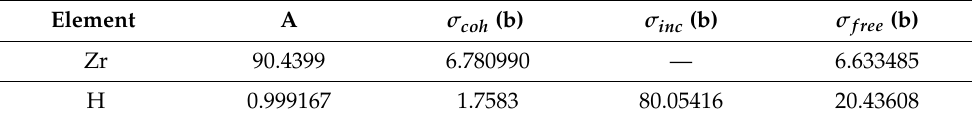
Table 1. Elemental scattering cross sections used in the present TSL evaluations for ZrH x . The co- herent and incoherent cross sections are bound. Each free atom cross section represents an isotopic average of the ENDF/B-VIII.0 neutron reaction sub-libraries at 0.0253 eV [25]. For hydrogen, the incoherent cross section corresponds to the Sears database [24], whereas the coherent scattering cross section is estimated as the difference between the bound total and bound incoherent scattering cross